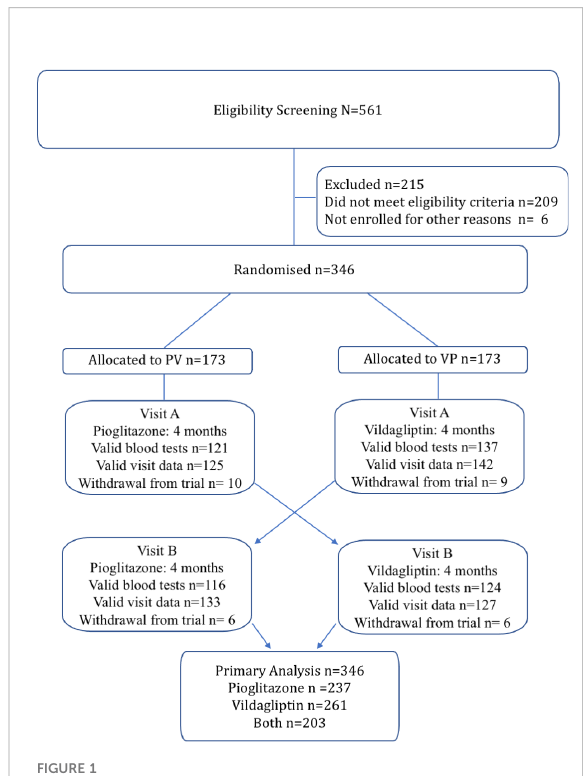
FIGURE 1 Flow diagram of the study participants included in this